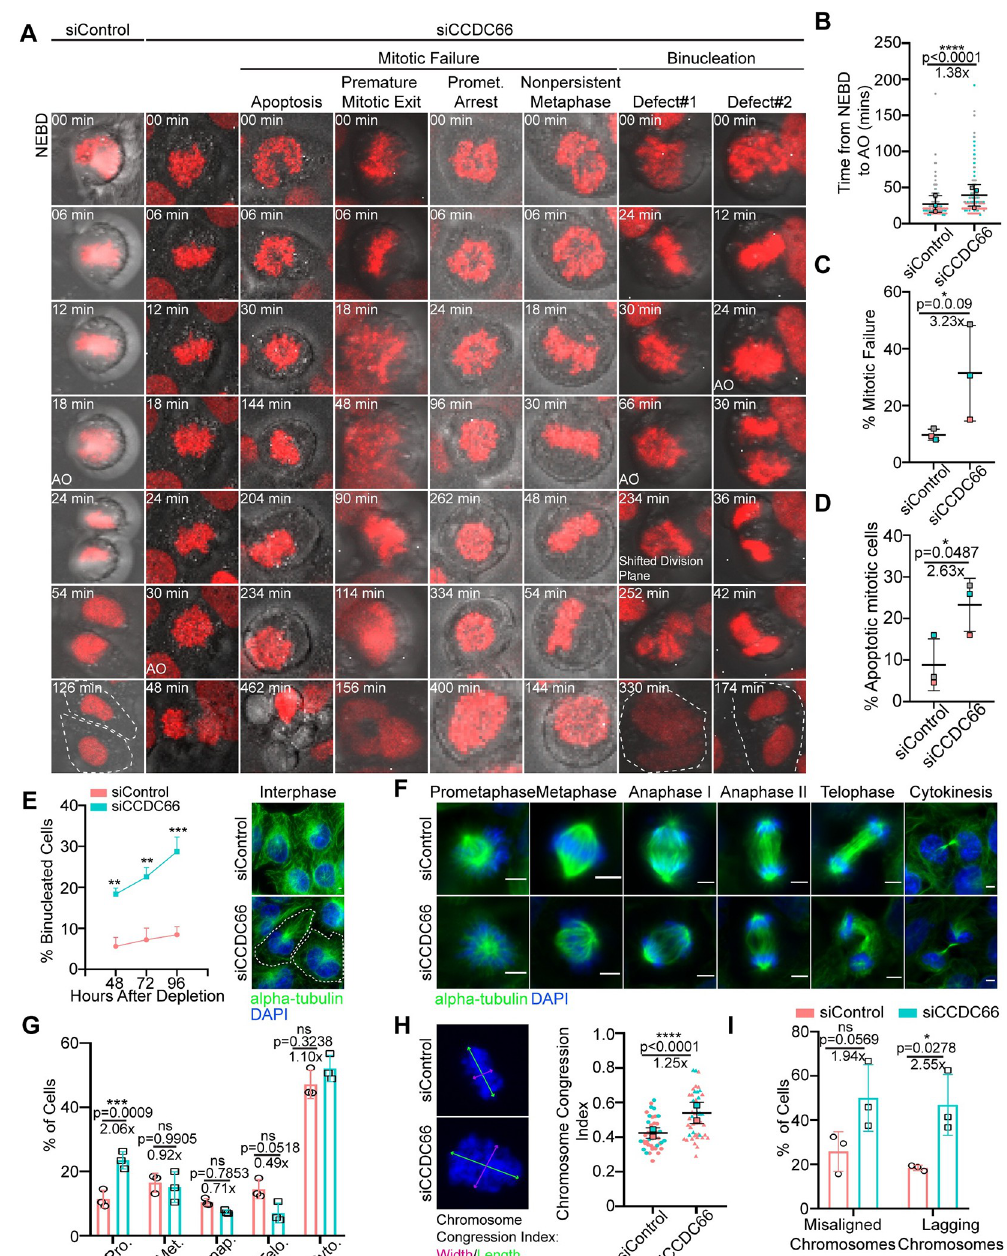
Fig 3. CCDC66 is required for faithful mitotic progression and cytokinesis. (A) Effects of CCDC66 depletion on mitotic progression. U2OS::mcherry-H2B cells were grown on 2-well Lab-Tek plates and transfected with nontargeting (siControl) or CCDC66 targeting (siCCDC66) siRNA. After 48 h of transfection, cells were imaged with confocal microscopy with 20 × objective. Images are acquired every 6 min for 12 h. Representative still images from live imaging are shown for different phenotypic categories for siCCDC66 include apoptosis, premature mitotic exit, prometaphase arrest, and nonpersistent metaphase. (B) Quantification of mitotic time from (A). Mitotic time was quantified as the time interval from NEBD to AO. Data represent the mean ± SEM of 3 independent experiments and is plotted using super-plot. (C) Quantification of percent mitotic failure from A. Mitotic failure refers to the cells that entered mitosis but could not proceed through anaphase because of: premature mitotic exit, prometaphase arrest, and nonpersistent metaphase. Data represent the mean ± SEM of 3 independent experiments and is plotted using super-plot. (D) Quantification of percent mitotic cell death from (A). Mitotic cell death represents mitotic cells that underwent apoptosis during the time of imaging. Data represent the mean ± SEM of 3 independent experiments and is plotted using super-plot. (E) CCDC66 depletion increases binucleation. Cells were transfected with either siControl or siCCDC66; fixed with methanol 48, 72, and 96 h post-transfection; and stained for alpha-